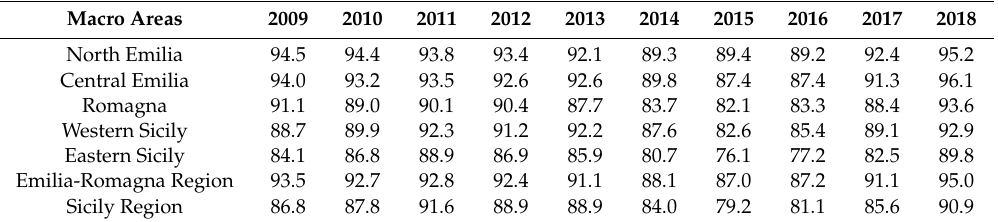
Table 1. Vaccine coverage rates at 24 months in the Emilia-Romagna and Sicily regions.